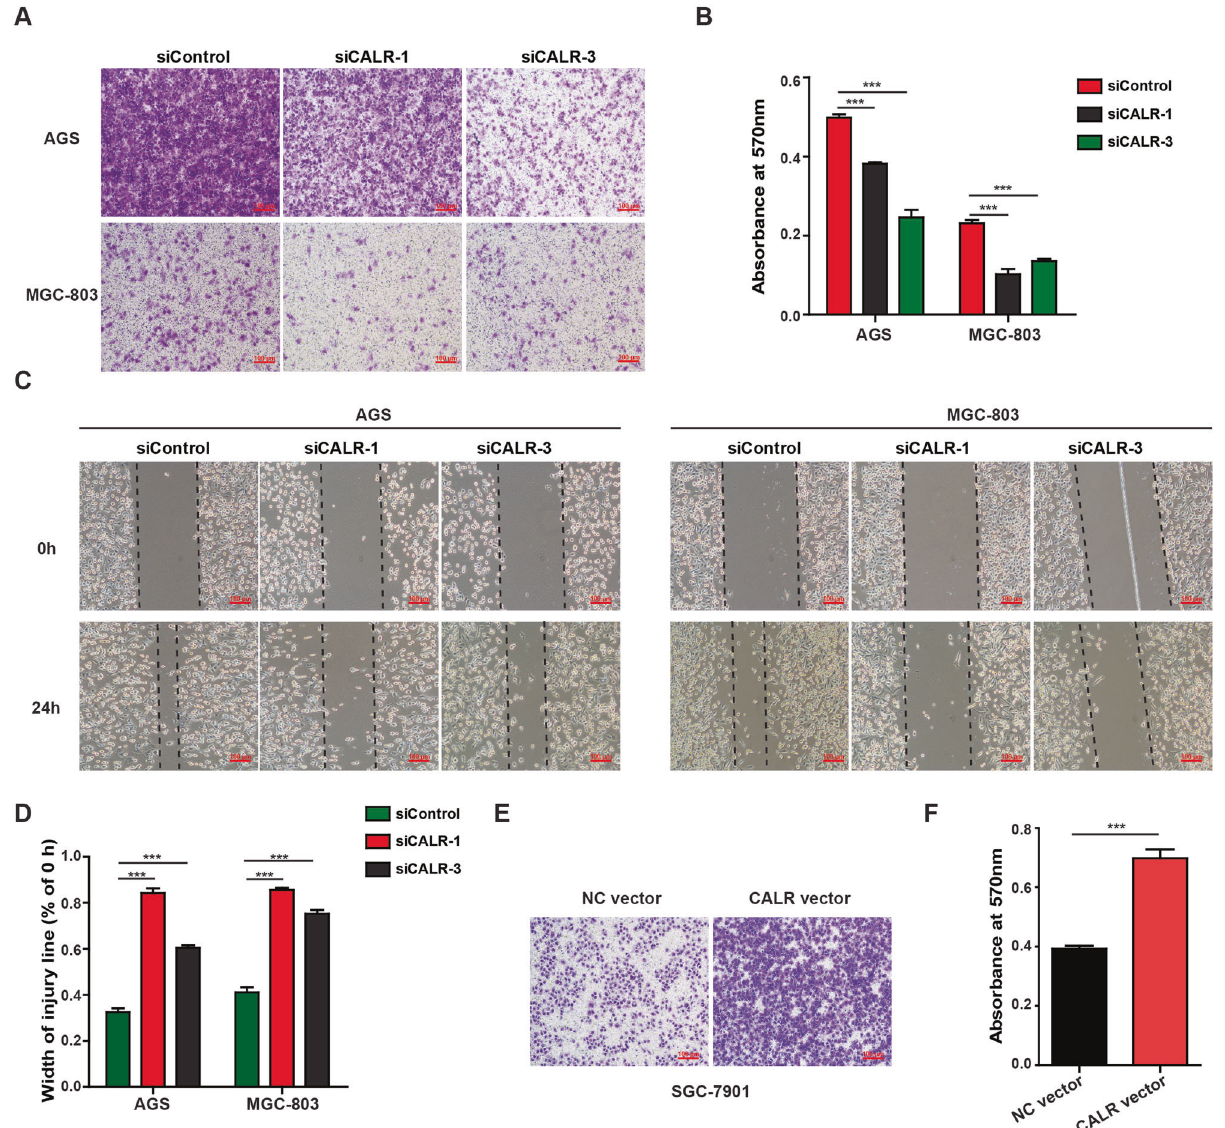
Fig. 2 The effects of CALR on GC cells migration in vitro. A , B Transwell assays and ( C and D ) wound healing assays detecting migration abilities of GC cells transfected with CALR siRNAs or control in AGS and MGC-803 cells (scale bar = 100 μ m). Wound healing was quanti fi ed by measurement of the average linear speed of movement of the wound edges. E , F Representative photomicrographs of transwell assays results for SGC-7901 cells infected with NC vector or CALR vector (scale bar = 100 μ m). All of the experiments were performed three times. Data are presented as mean ± SEM. * P < 0.05, ** P < 0.01, *** P <